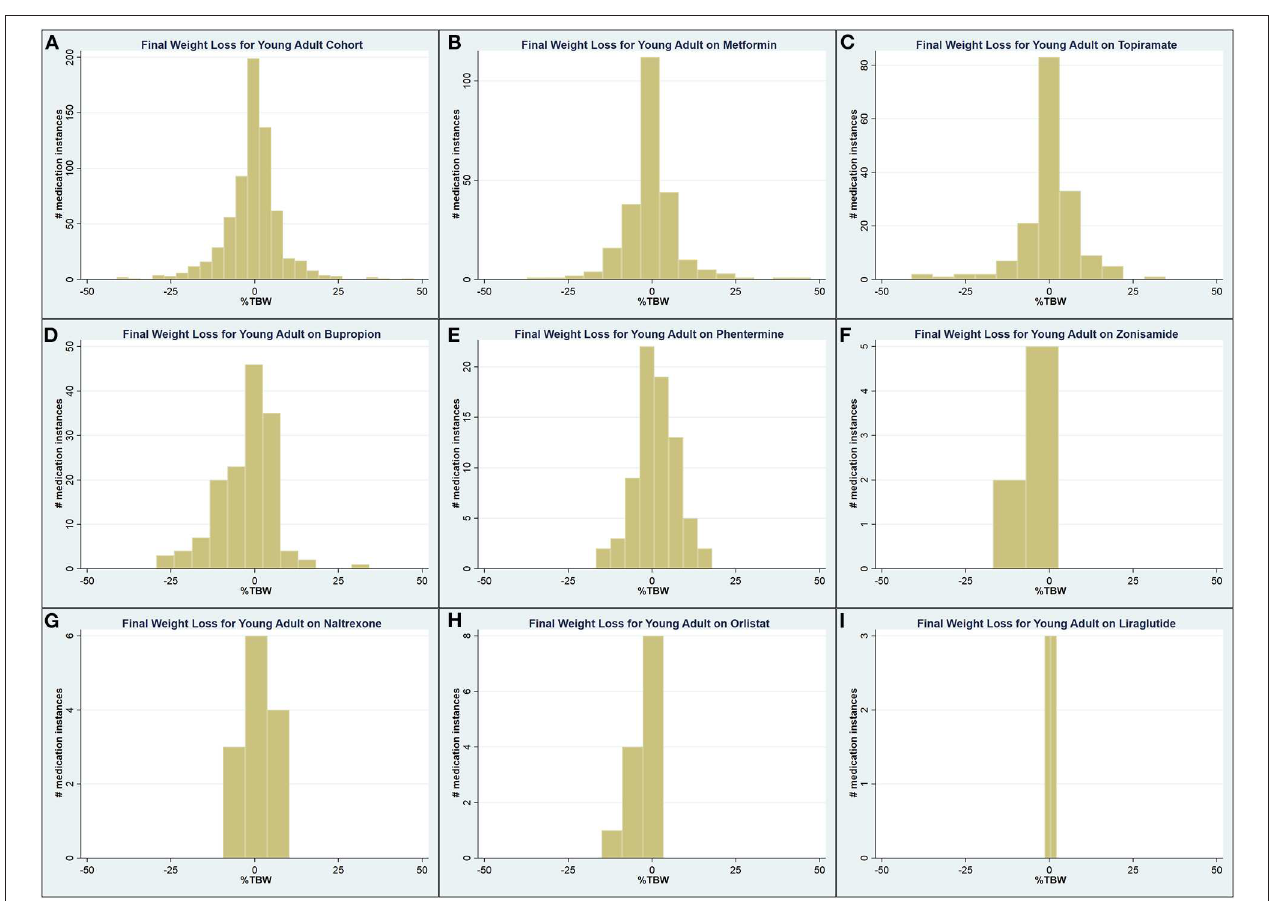
FIGURE 3 | Graphical representation of the final weight loss distribution in young adult cohort (A) across all medications, (B) on metformin, (C) on topiramate, (D) on bupropion, (E) on phentermine, (F) on zonisamide, (G) on naltrexone, (H) on orlistat, and (I) on liraglutide.